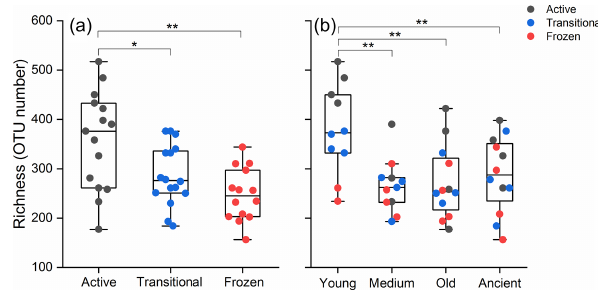
Figure 2. Bacterial richness with the permafrost thawing status (a) and age (b) . The richness is indicated by operational taxo- nomic unit (OTU) number. Different letters indicate significant dif- ference at P < 0 . 05. Young, medium-aged, old, and ancient are per- mafrost soil ages; active, transitional, and permanently frozen are permafrost thawing